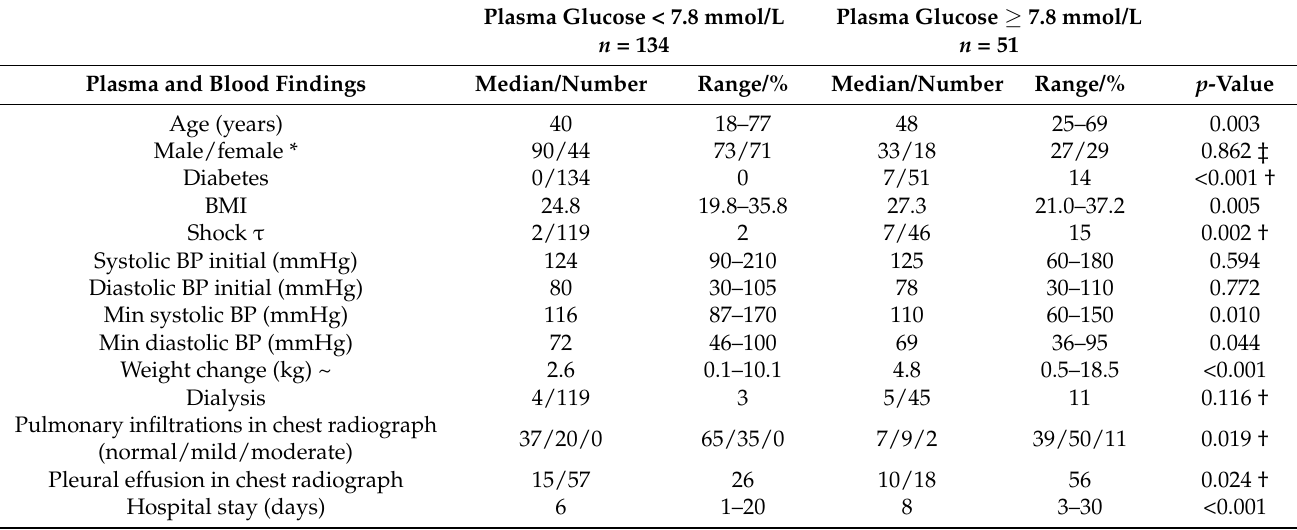
Table 1. Clinical findings in 185 patients with PUUV infection according to maximum plasma glucose concentration.